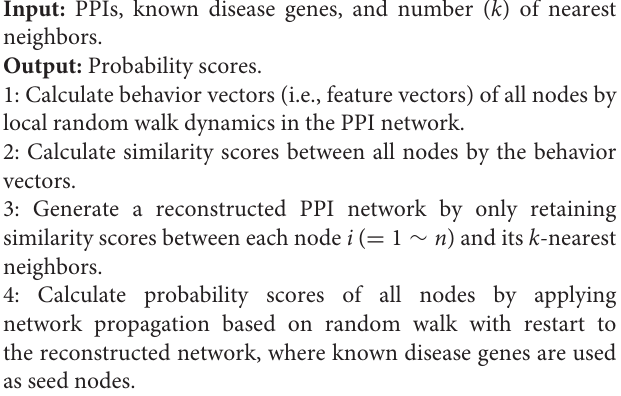
Algorithm 1 | RCRWR